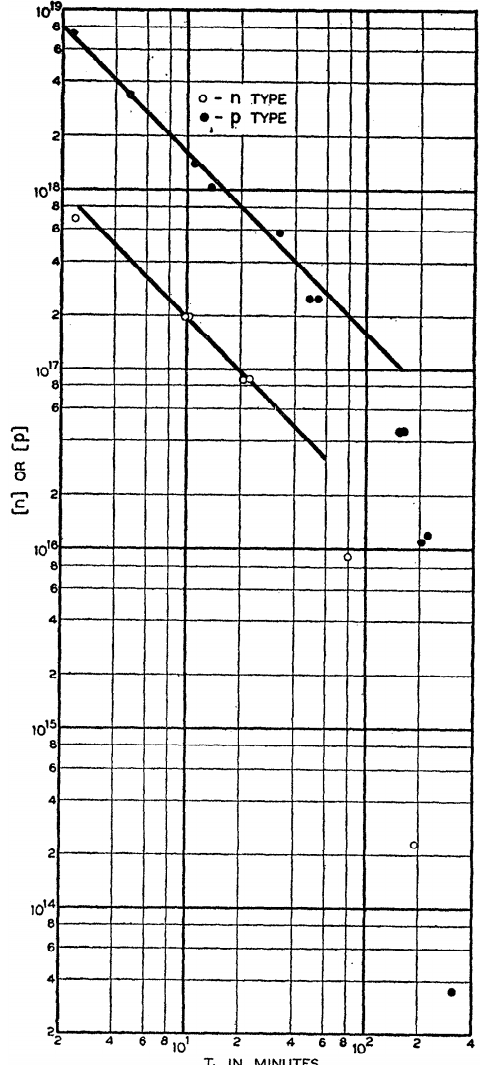
Figure 4. Plot of 29 Si spin-lattice relaxation times versus mobile carrier concentration. (Reprinted figure with permission from Reference [18] © (1956) by the American Physical Society).